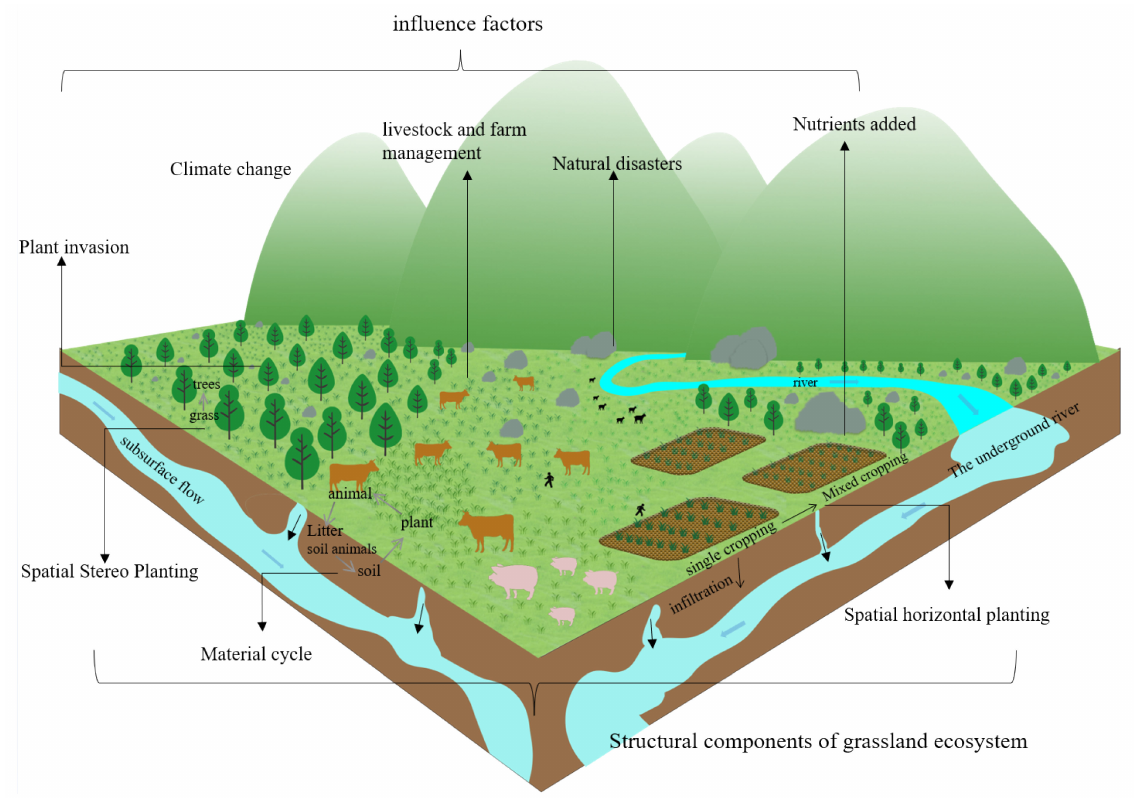
Figure 4. The structural components of grassland ecosystems and the factors that influence them combine to influence grassland ecosystem